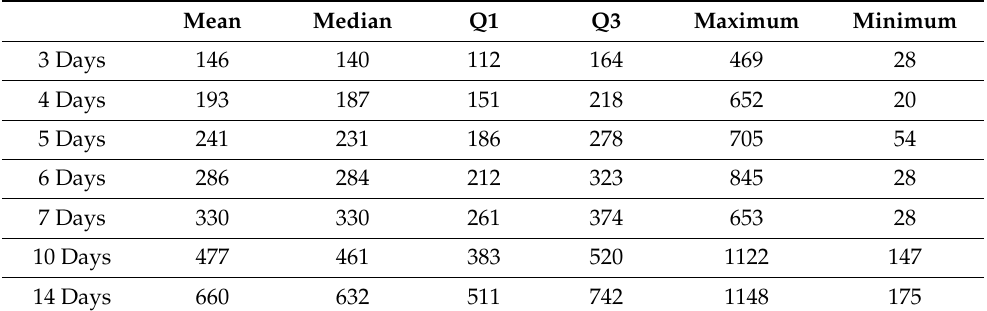
Table 1. Basic statistics for the concentration of abnormal idle time for the seven different periods of interest.